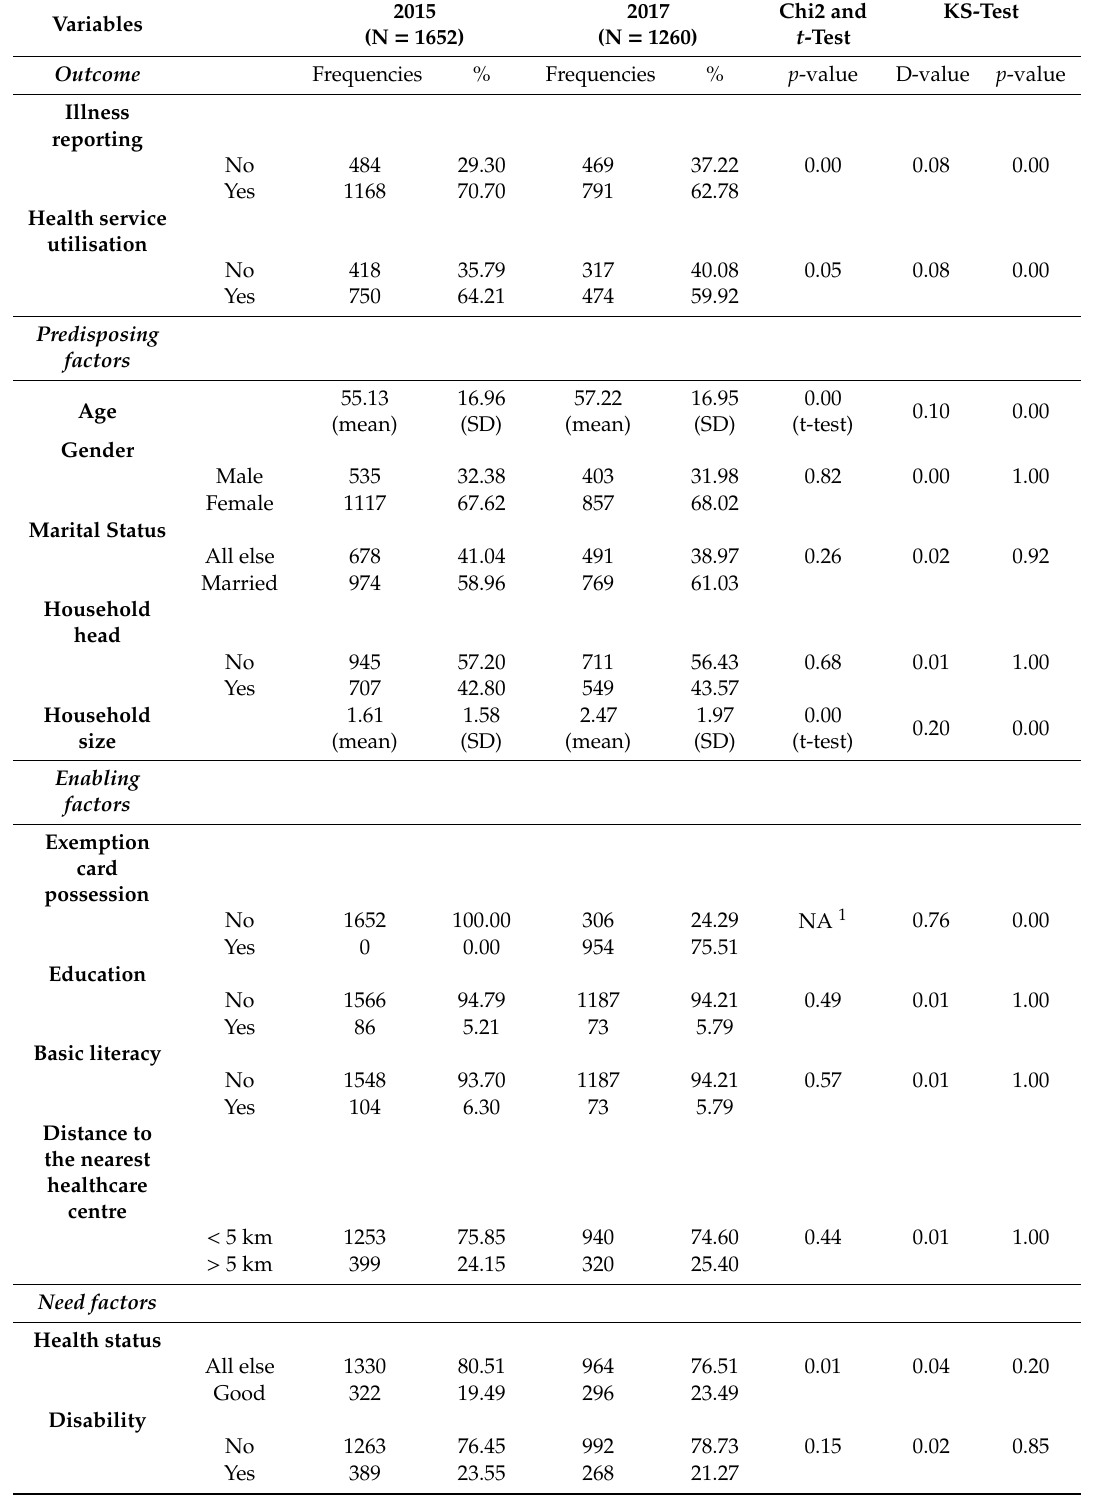
Table 3. Comparison of the study sample characteristics 2015 and